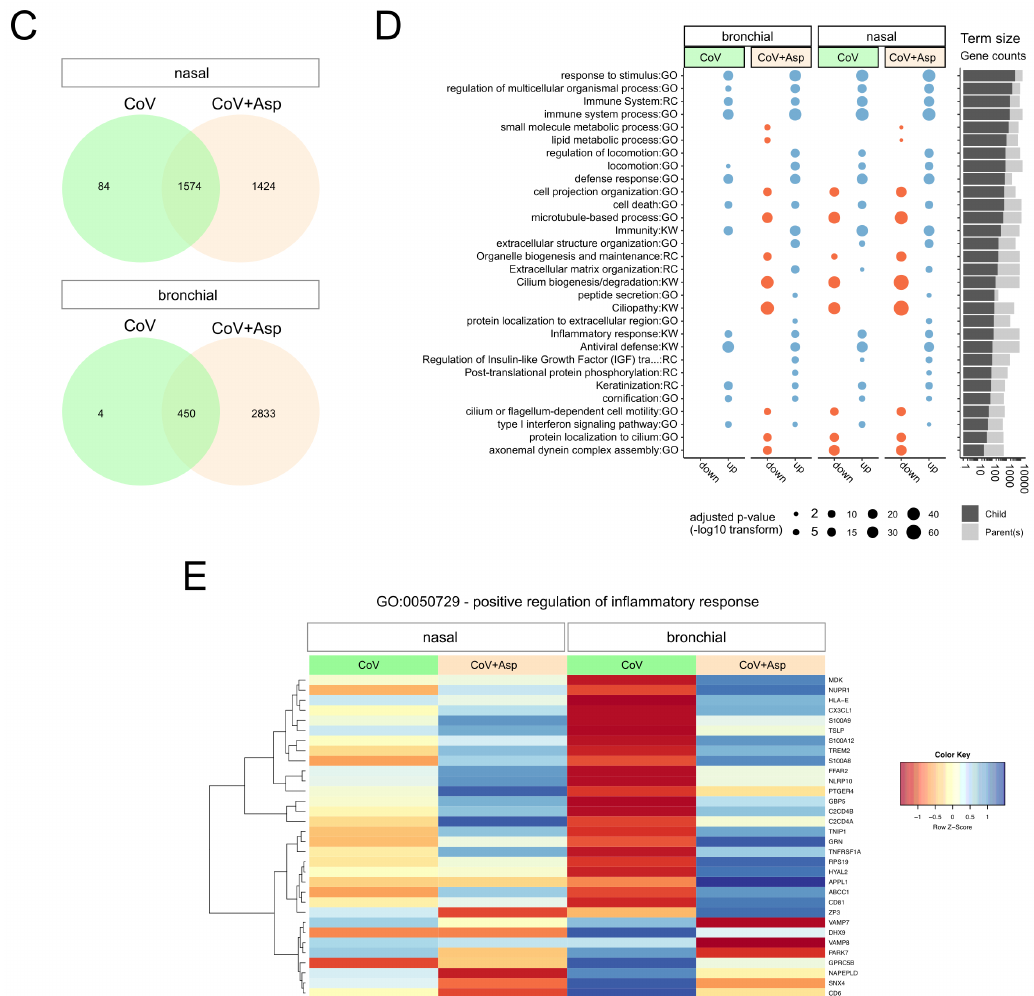
Figure 1. ( A ) Overview of experimental strategy. ( B ) At 72 h post-infection, for both nasal and bronchial human airway epithelia (HAE) model, the relative viral production (intracellular) was determined using RTqPCR, and the impact of infection on epithelium integrity was monitored by the measure of the transepithelial resistance (TEER Ohms / cm 2 ). IL-6 was measured at the apical using a specific ELISA assay. * p < 0.05; ** p < 0.01; *** p < 0.001. ( C ) Nasal and bronchial gene signature overlap for SARS-CoV2 or SARS-CoV-2 + Aspergillus infected conditions vs. Mock. We contrasted the significantly differentially expressed gene lists corresponding to CoV vs. Mock and CoV + Asp vs. Mock in nasal and bronchial HAE. Only genes above threshold (log2(FC) > 1 or < − 1 compared to the mock-infected condition and Benjamini–Hochberg adjusted p -value < 0.01) were considered. ( D ) Overview of functional enrichment results for SARS-CoV2 or SARS-CoV-2 + Aspergillus infected conditions vs. Mock. Considering (CoV vs. Mock) and (CoV + Asp vs. Mock) for both bronchial and nasal HAE, significantly up- or down-regulated gene lists ( x -axis) were tested for significant enrichment using the parent-child strategy (see methods). If below the threshold, the adjusted p-values corresponding to different terms ( y -axis) are represented by point sizes (see legend). After clustering terms based on gene occurrences (binary distance and Ward algorithm) in 15 metagroups, only the top two (lowest adjusted p-value) were represented here. For the complete list of significant terms, see Figure S1. The bar plot on the right represents the sizes of enriched terms (called child) in comparison to the size of their parents (see Section 2). ( E ) Positive regulation of the inflammatory response in nasal and bronchial HAE. We extracted the list of proteins associated with the term GO:0050729 and visualized the scaled log-transformed expression results in a heatmap. Each row represents a gene, and each column is an experimental condition. The color key indicates the scaled expression levels vs. Mock (red, low; blue,